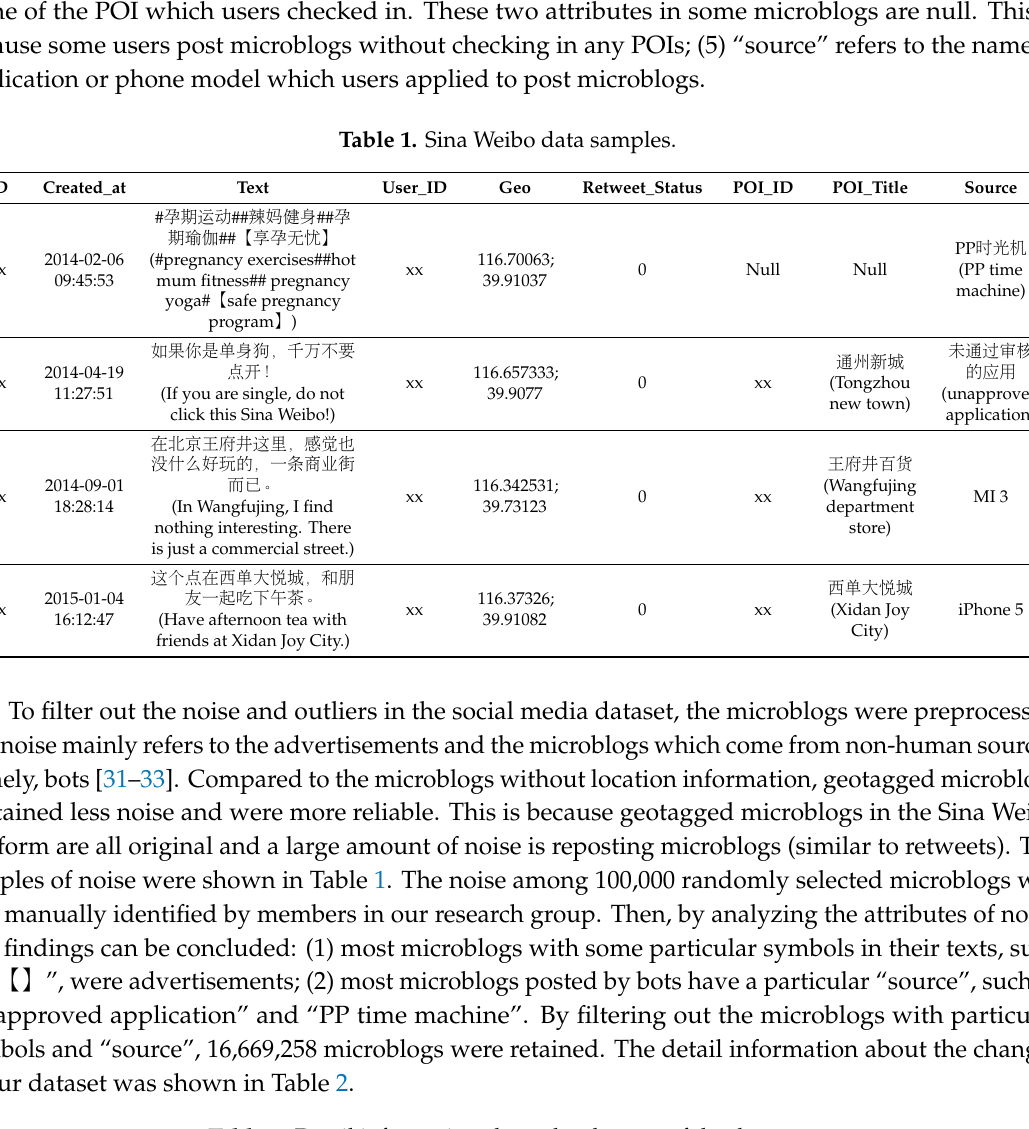
Table 2. Detail information about the changes of the